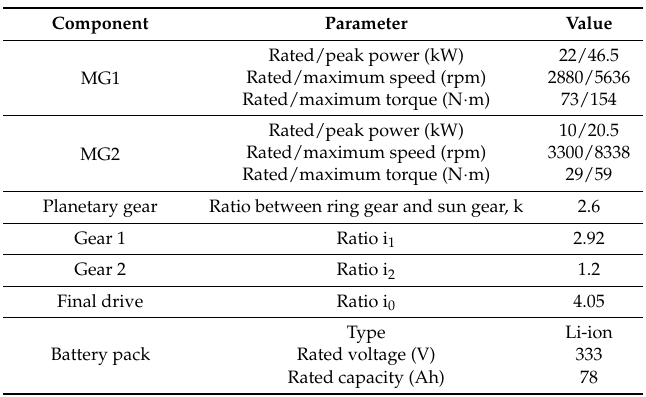
Table 3. Parameters of the powertrain